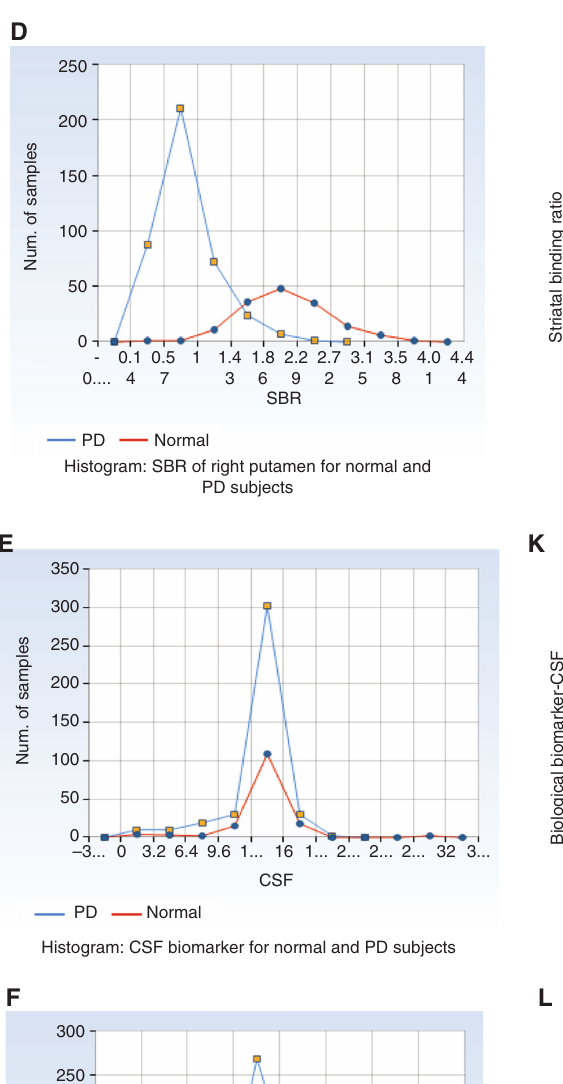
Box plot-CSF biomarker for normal and PD subjects Biological biomarker (urine) for normal and early PD subjects